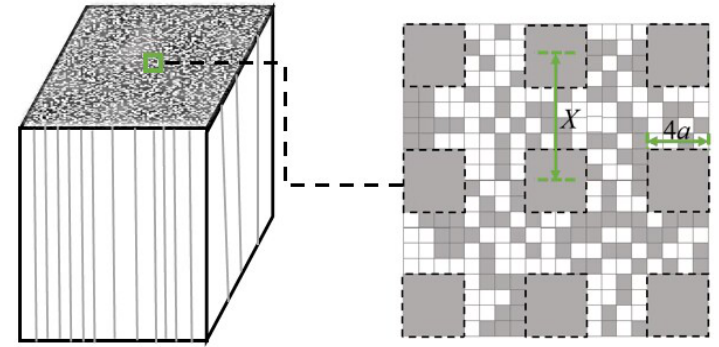
Figure 4. The cross-section schematic of the novel G-DOF.